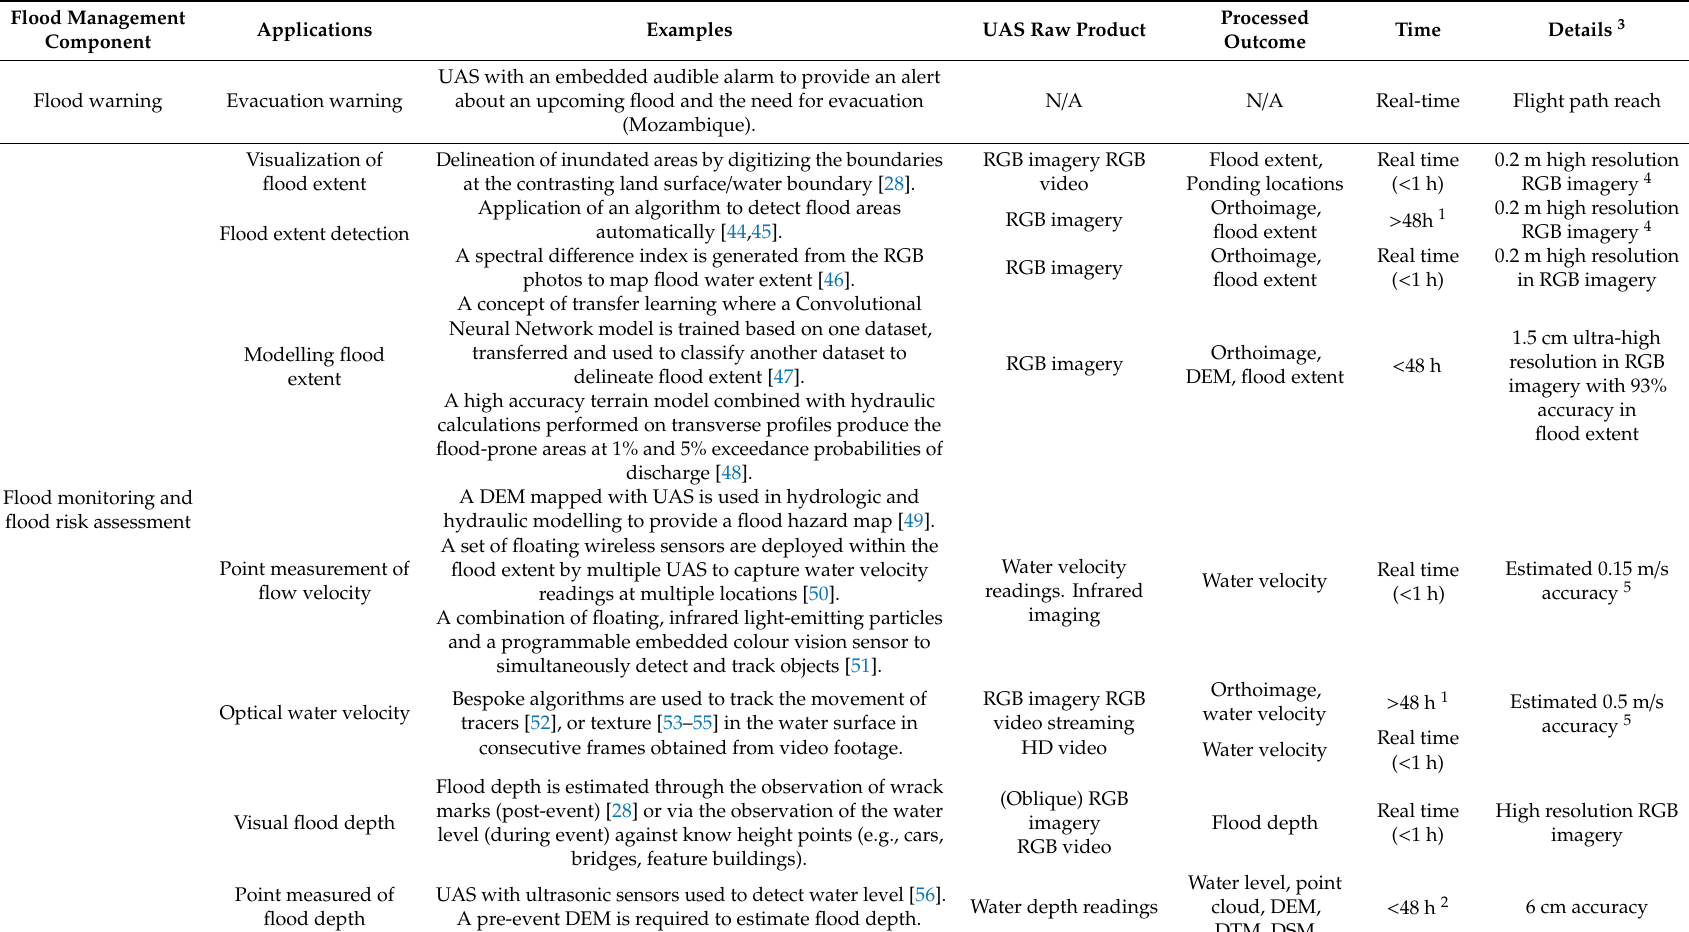
Table 2. Detailed list of flood risk management components, with identified applications, UAS raw products and post-processed outcomes from the literature within the context of flood emergency response. The processing time for outcome generation and the accuracy of the outcome is also indicated. DEM, DTM and DSM stand for Digital Elevation Model, Digital Terrain Model and Digital Surface Model,